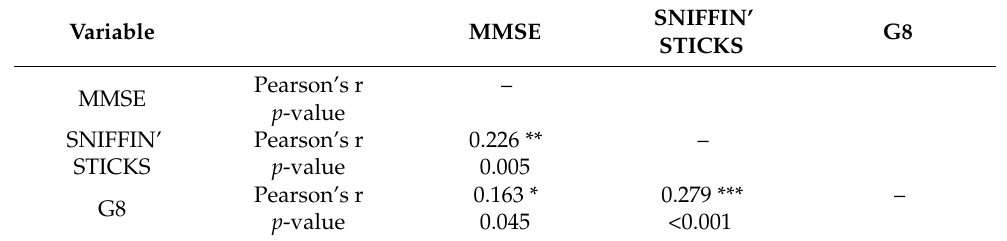
Table 5. Pearson’s coefficient and and p -value for significant correlations are reported.